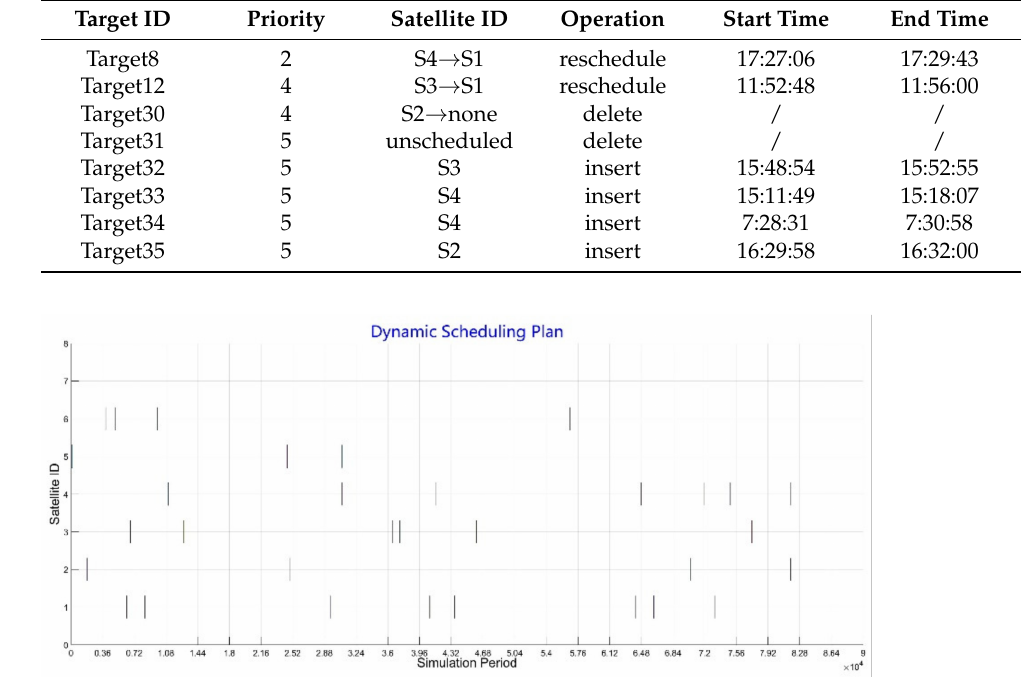
Table 8. Dynamic scheduling plan.